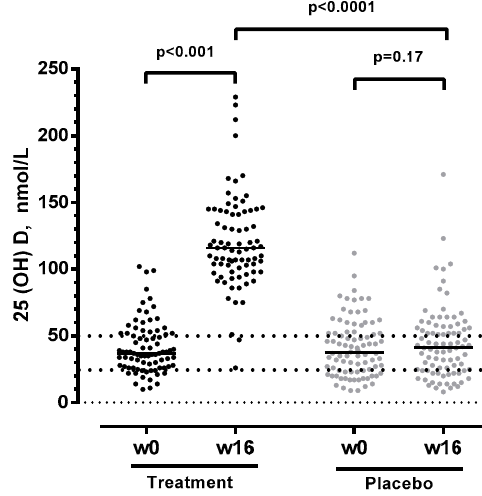
Figure 1. Vitamin D status assessed at baseline and at weeks 16 after daily supplementation with 5000 IU vitamin D and 500 mg phenylbutyrate ( n = 81), or placebo ( n = 86). P values are generated by Wilcoxon signed-rank and Mann-Whitney U test.